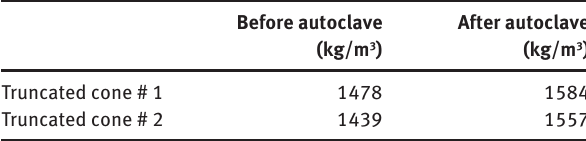
Figure 6: Surface finish of the thermoplastic truncated cone before and after autoclave treatment. Table 6: Density measurement before and after autoclave